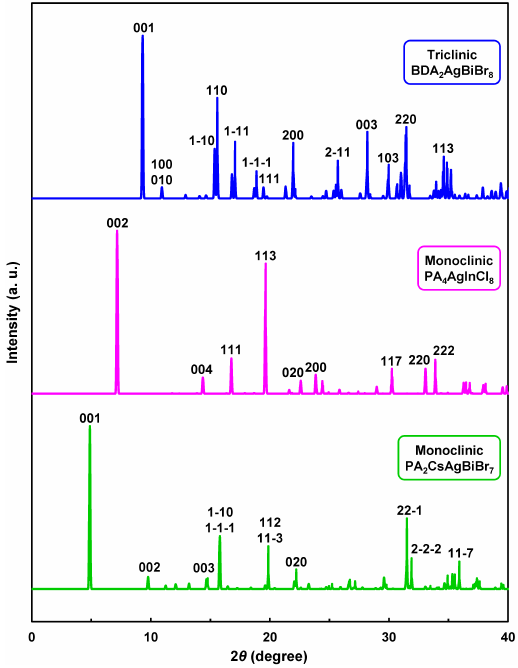
Figure 39: Calculated X-ray diffraction patterns of (NH 3 (CH 2 ) 4 NH 3 ) 2 AgBiBr 8 , (CH 3 (CH 2 ) 2 NH 3 ) 4 AgInCl 8 , and (CH 3 (CH 2 ) 2 NH 3 ) 2 CsAgBiBr 7 with 2-dimensional double perovskite